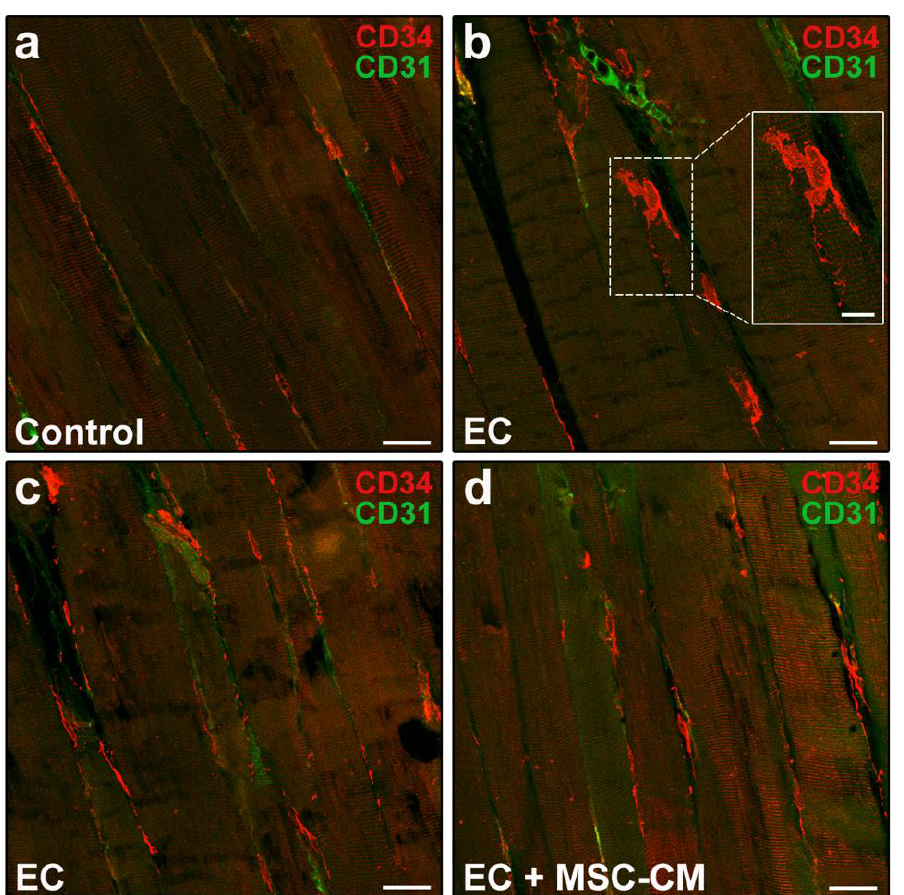
Figure 4. Morphological evaluation of telocytes in formalin-fixed and paraffin-embedded tissue sections from control EDL muscles, EDL muscles damaged by ex vivo forced eccentric contraction (EC) and EDL muscles damaged by EC in the presence of bone marrow-mesenchymal stromal cell (MSC) conditioned medium (EC + MSC-CM). ( a – d ) Representative confocal immunofluorescence images of muscle tissue sections immunostained with antibodies against CD34 (red) and the pan- endothelial cell marker CD31 (green). Telocytes are identified as CD34 + /CD31 − stromal cells with distinctive moniliform cytoplasmic prolongations (telopodes), while vascular structures are CD31 + . Higher magnification of the boxed area in ( b ) depicting a typical telocyte is shown in the inset. Images are representative of at least 3 sections from each of 4 control, 4 EC and 4 EC + MSC-CM muscles. Scale bars = 25 μm ( a–d ), 10 μm (inset in b ).